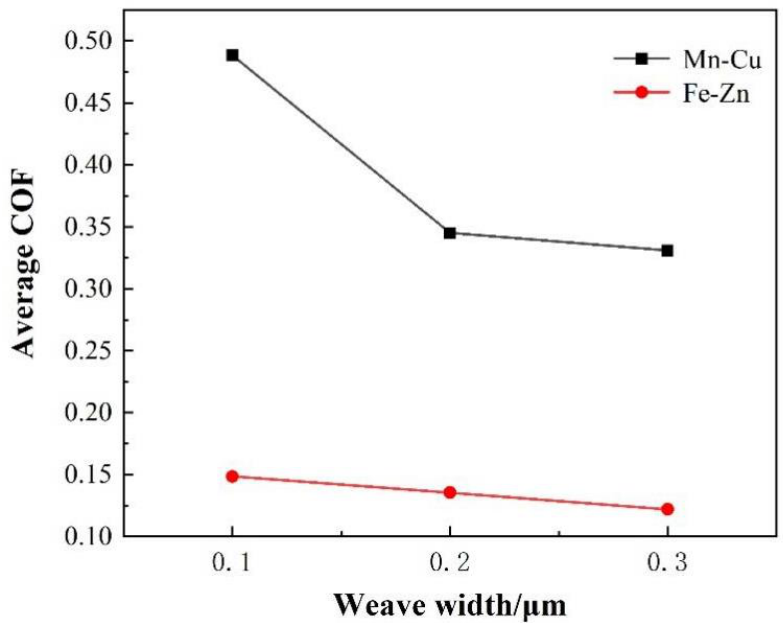
Figure 4. Average friction coefficients of the Mn-Cu and Fe-Zn samples with the different weave width.